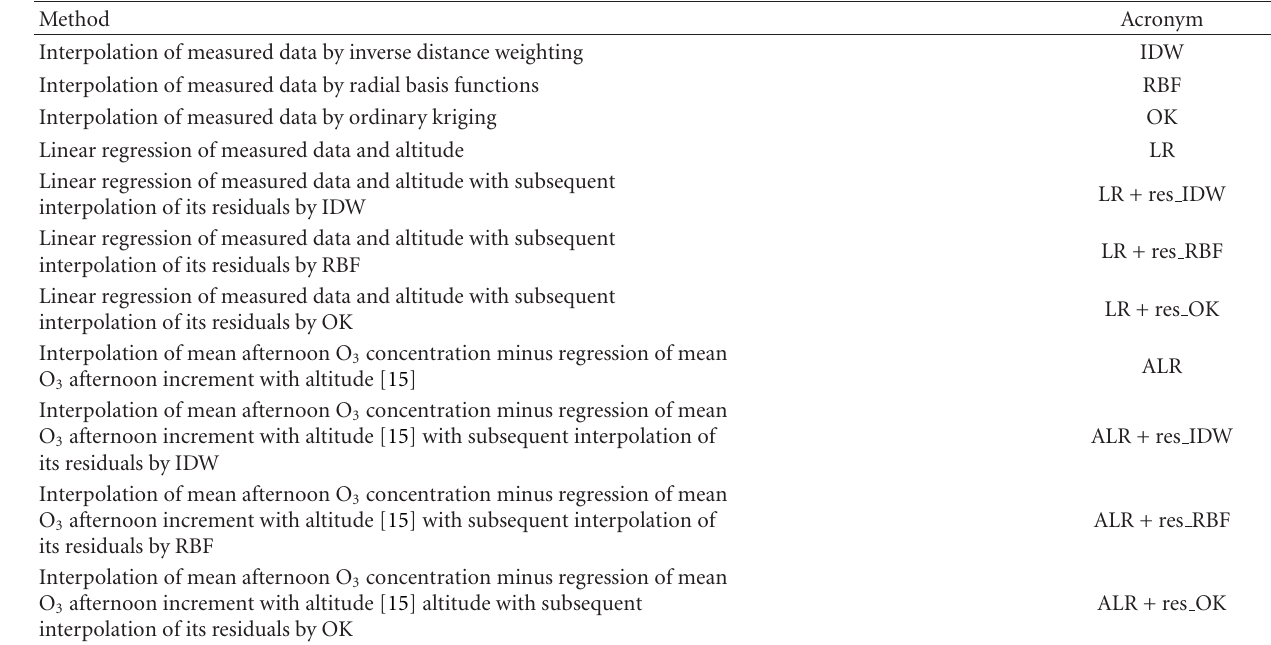
Table 1: Methods used for